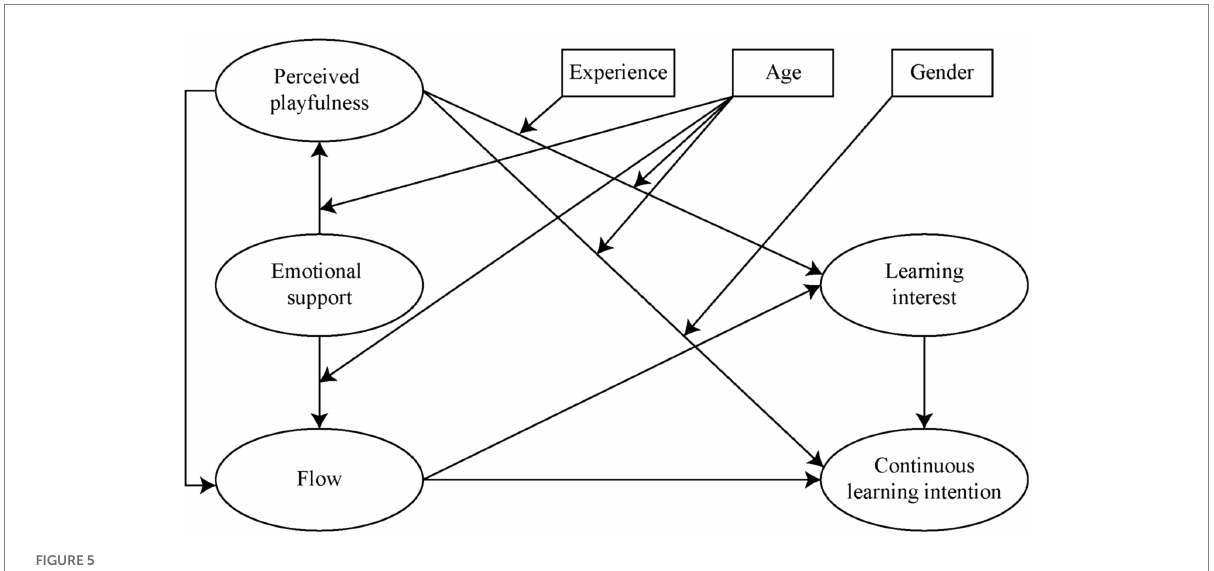
FIGURE 5 Emotion-driven learning model